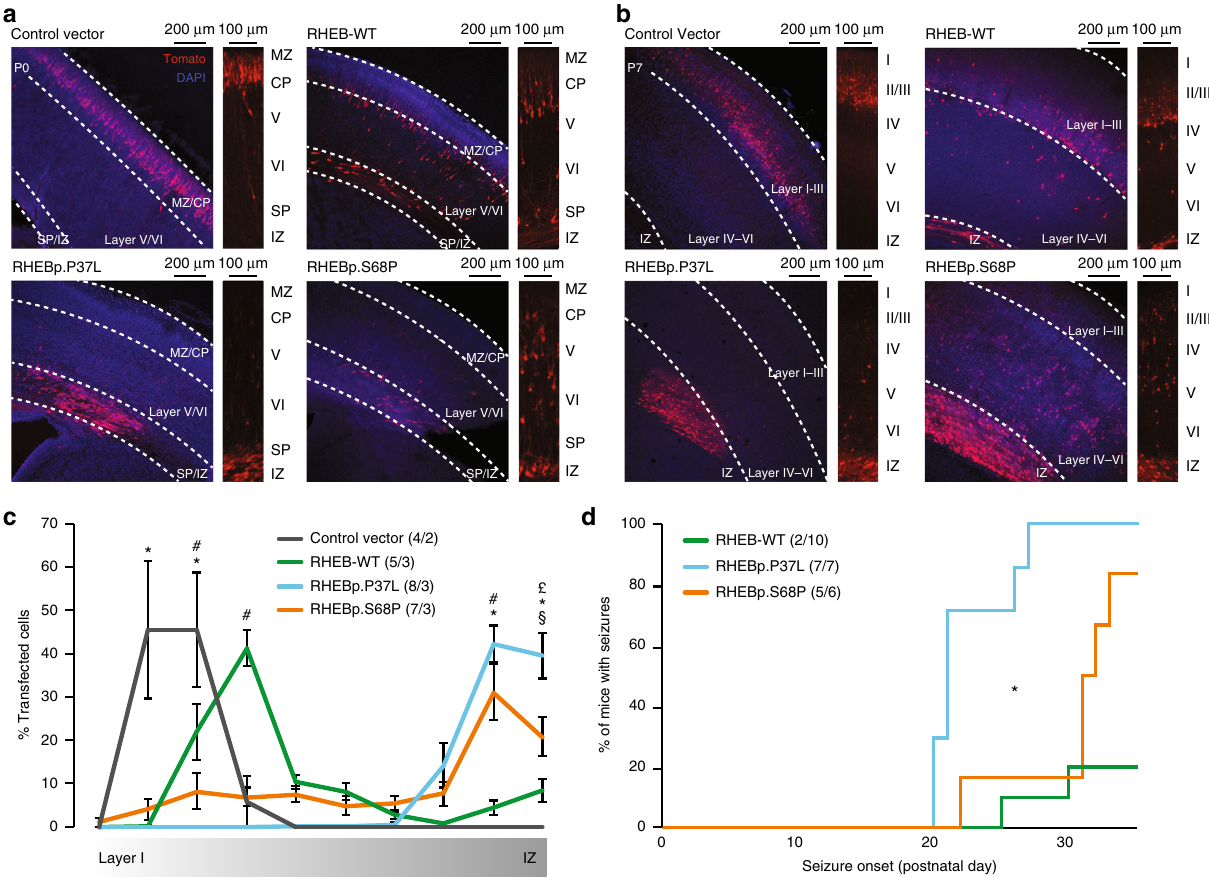
Fig. 4 Overexpression of RHEB mutants in vivo causes de fi cits in neuronal migration and seizures in mouse. a , b Representative images of E14.5 in utero electroporated P0 brains ( a ) or P7 brains ( b ), with an enlargement showing the migratory pathway of the transfected cells (tdTomato+) from the intermediate zone (IZ) and subplate (SP) to the more super fi cial layers of the cortex (CP = cortical plate and MZ = marginal zone). c Quanti fi cation of the neuronal migration pattern observed in different conditions. Data are presented as mean ± SEM. Statistical signi fi cance was assessed by two-way repeated measure ANOVA followed by Bonferroni ’ s post hoc test (for bins 2 – 4: *indicates signi fi cant difference between control vector and the different RHEB conditions ( p < 0.0001); # indicates signi fi cant difference between the RHEB-WT and all other conditions ( p < 0.0001); for bins 9 and 10: *indicates signi fi cant difference between control vector and RHEBp.P37L and RHEBp.S68P; # indicates signi fi cant difference between RHEB-WT and RHEBp.P37L and RHEBp.S68P ( p < 0.0001)); § indicates signi fi cant difference between RHEB-WT and RHEBp.P37L ( p < 0.0001); £ indicates signi fi cant difference between RHEBp.P37L and RHEBp.S68P ( p < 0.001). d Kaplan – Meier graph representing onset of tonic – clonic seizures in successfully targeted mice. The insert legends of the graph show N pictures / N mice ( c ) or N seizure / N total ( d